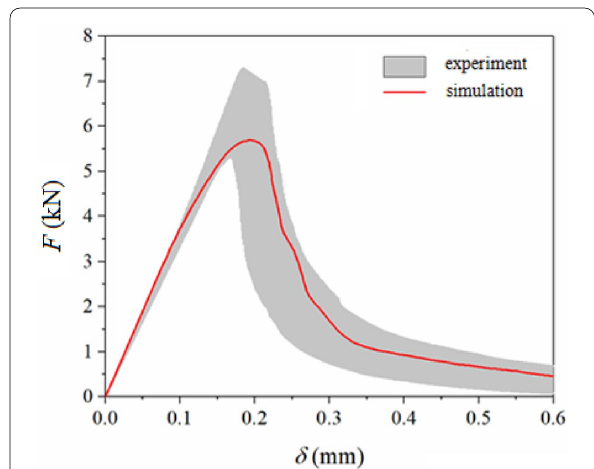
Fig. 10 Comparison between experimental and numerical load– displacement